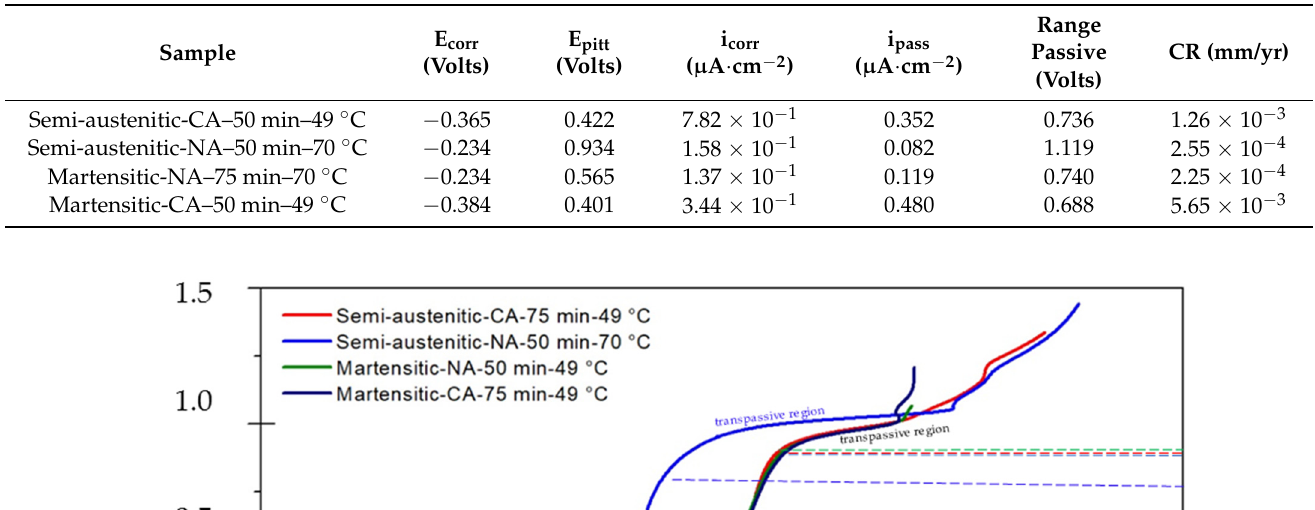
Table 4. Parameters obtained by PP for passivated martensitic and semi-austenitic. PHSS in 5 wt.% NaCl solution.